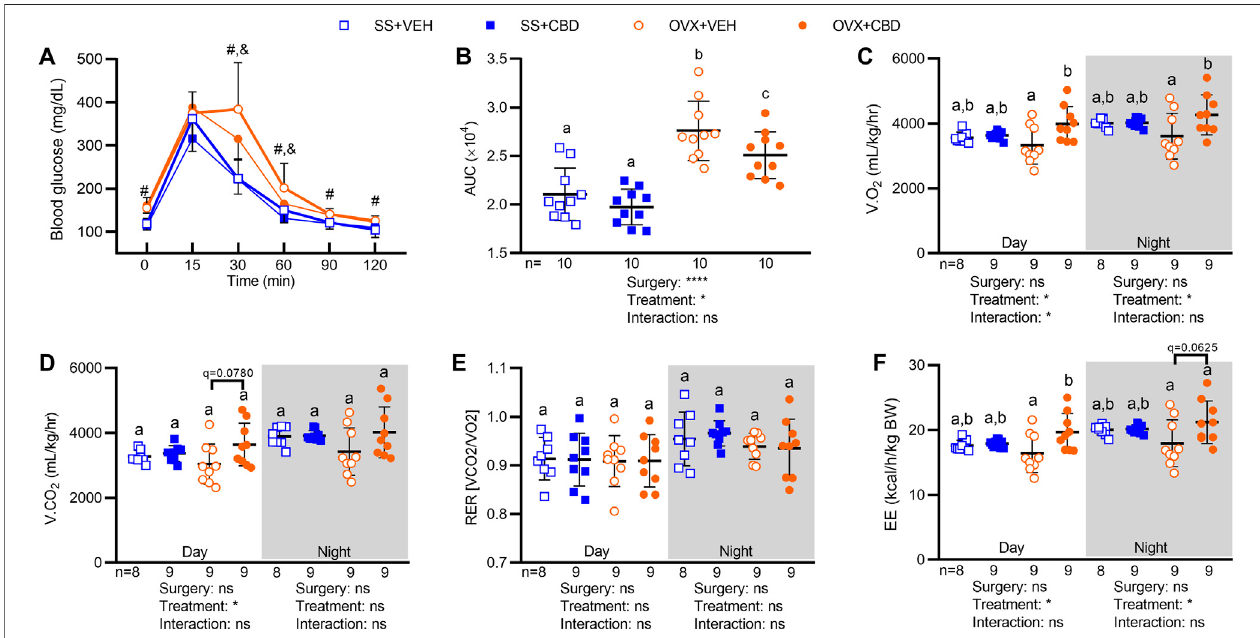
FIGURE 1 | CBD increased oral glucose tolerance, O2 consumption, and energy expenditure in OVX mice. (A) After 9 weeks of CBD or VEH treatment, blood glucose readings were taken at 0, 15, 30, 60, 90 and 120 min after oral glucose challenge (2 mg/kg), n = 10 mice/group. (B) Oral glucose tolerance data in (A) represented as area under the blood glucose curves (AUC). Indirect calorimetry performed between 9 and 10 weeks on 9 mice/group showing (C) volume of oxygen consumed,V.O2, (D) volumeofcarbondioxideproduced,V.CO2 (E) respiratoryexchangeratio,RER,and (F) energyexpenditure,EE(askcalsexpendedperhour normalized to body weight in kg). Data are mean ± SD. The ROUT test was performed to detect outliers. 2-way ANOVA was performed followed by the Benjamini – Hochberg post-hoc test with FDR adjustment, q < 0.05. The 2-way ANOVA results for panel A are summarized in Supplementary Table S1 . In panel A, pound (#) sign denotes signi fi cant difference between SS groups and OVX groups and ampersand (&) sign denotes signi fi cant difference between OVX+VEH and OVX+CBD groups, as determined by Benjamini – Hochberg posthoc test. Two-way ANOVA results are indicated under graphs (B – F) . Different letters (a – c) indicate signi fi cant differences determined by the Benjamini – Hochberg post-hoc test with FDR-adjusted p values, q < 0.05.